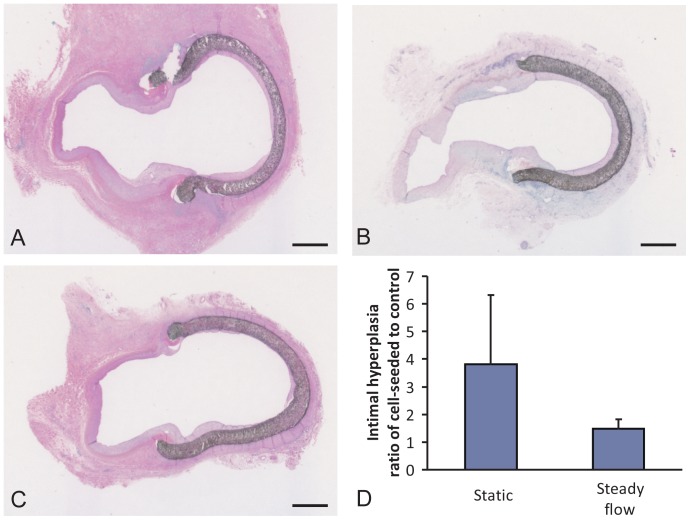
Baboon implant results.Representative hematoxylin and eosin histology stains are shown for each of the treatment groups: static, EOC-seeded grafts (A), EOC-seeded grafts pre-treated with steady 10 dynes/cm2 fluid shear stress for 24hrs prior to testing (B), and bare, unmodified ePTFE (C). Scale bar equals 1 mm. Intimal hyperplasia quantification after 4wks in a baboon graft model is shown for the cell-seeded samples as a ratio to their internal, unmodified control (D). ANOVA, p = 0.18. N≥4.